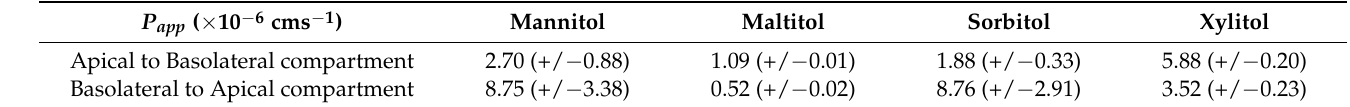
Table 4. Mean P app (+/ − standard deviation) of four polyols alone, basolateral to apical and apical to basolateral Caco-2 permeability assay.